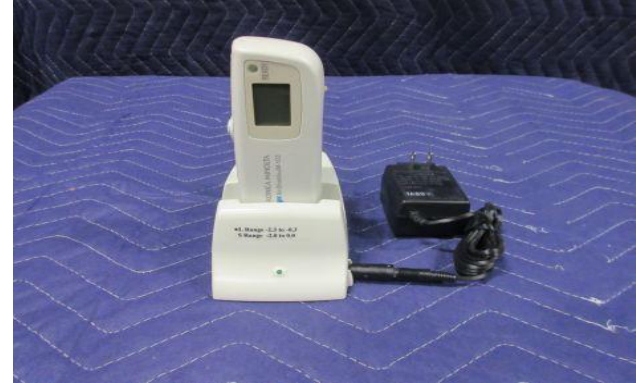
Figure (1): JM 103 Minolta Air Shields Transcutaneous